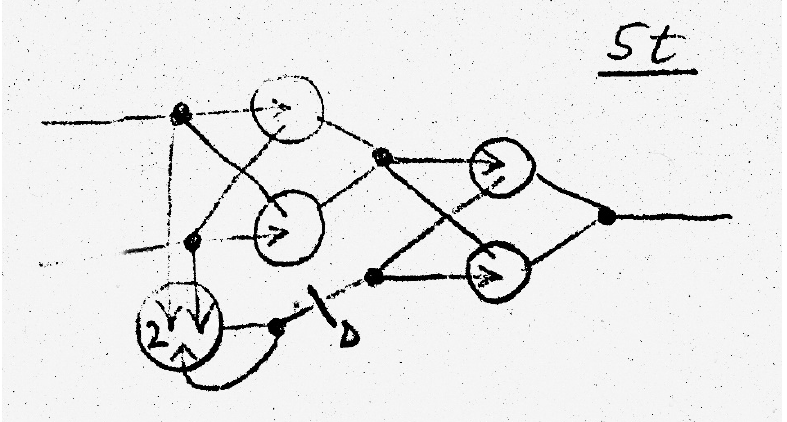
Figure 4. This logic diagram from von Neumann’s ‘LA Notes’ shows the Lecture 3 adder. Again, stimulating inputs into the neurons are indicated by an arrowhead, and in this diagram inhibitory inputs into the neurons are indicated simply by the absence of an arrowhead. The device labelled ‘D’ (for ‘Delay’) has been replaced in the Lecture 3 diagram (Figure 3) by Neuron V. D’s function is simply to delay the signal, so the ‘carry’ digit arrives at the right moment; and neuron V in the Lecture 3 diagram performs the same function. Notice, by the way, the returning arc on the bottom left neuron, missing from the incorrectly drawn Lecture 3 diagram. Courtesy of the American Philosophical Society.